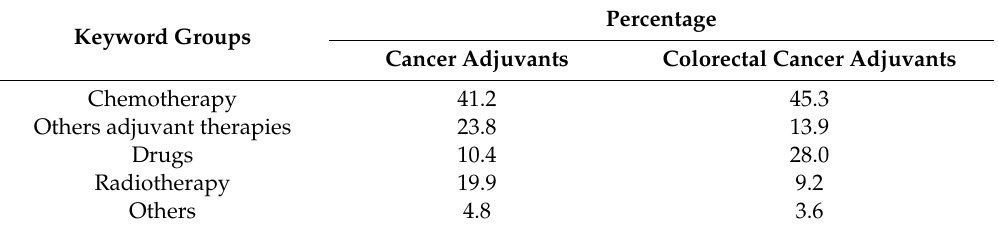
Table 1. Comparison of keyword groups in scientific papers for cancer adjuvants and colorectal cancer adjuvants. Two thousand papers were extracted from Scopus and examined in their keywords and the documents up to 31 / 12 / 2018; the keywords were grouped using VantagePoint.